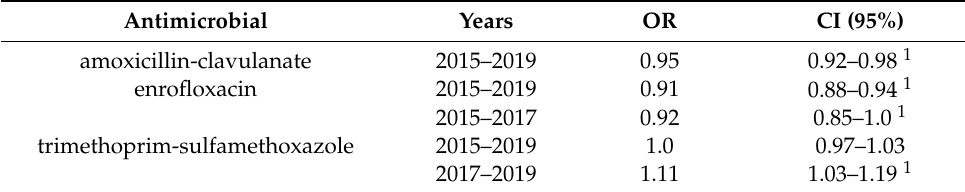
Table 1. Statistic parameters regarding the increase or decrease of resistance values within the five-year period for the three clinically relevant antimicrobials (Figure